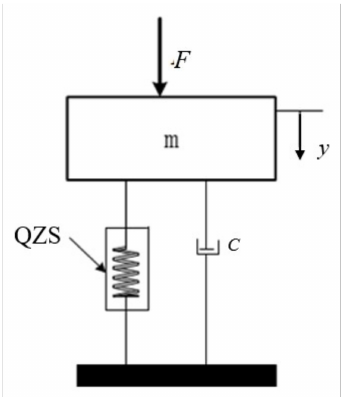
Figure 3. Schematic diagram of QZS-based vibration